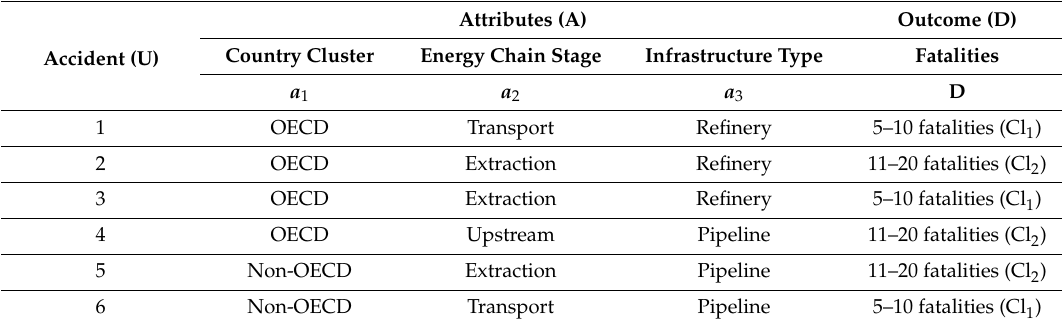
Table 2. Simplified information table for energy accidents from ENSAD.